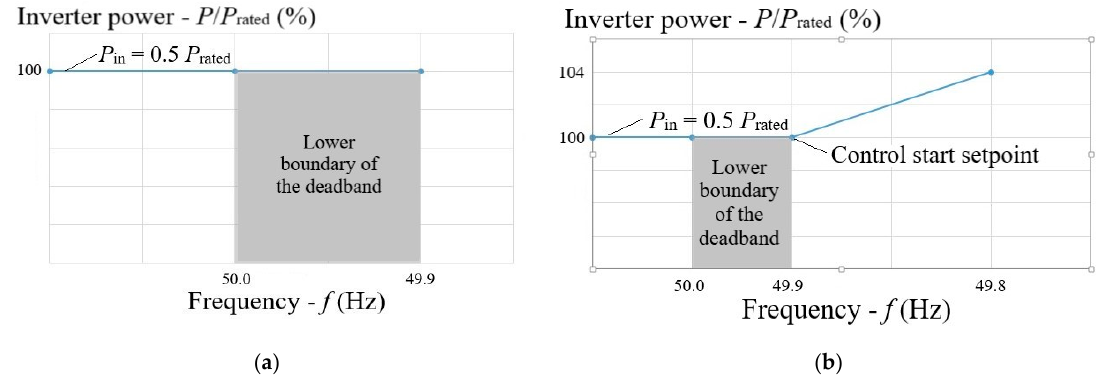
Figure 6. ( a ) A graph of testing the lower boundary of the deadband of the general primary fre- quency control; ( b ) a graph of the inverter power increase at f 1 = 49.8 Hz. 2.